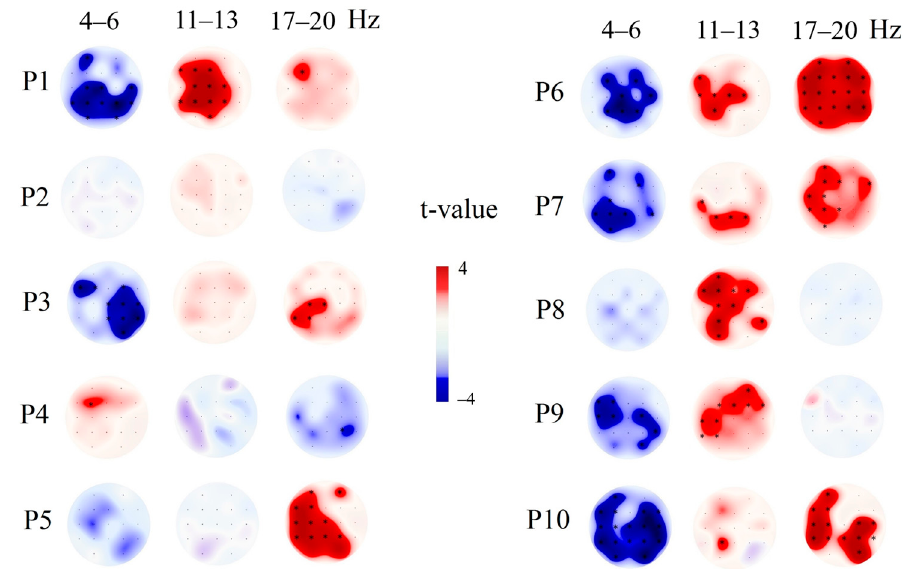
Figure 3. The individual differences in theta rhythm (4–6 Hz), alpha rhythm 11–13 Hz, and beta rhythm PSD between tactile stimulation (4*10 trials) and the resting state. P1-10—number of patient in accordance with Table 1. The individual differences between stimulus and rest were calculated using 4*10 trials of stimuli (each trial was 10 s long) and 40 10-s resting-state intervals. The differences were calculated for each patient separately; the Bonferroni correction was applied (p< 0.0026). The black stars indicate a significant difference after Bonferroni correction.